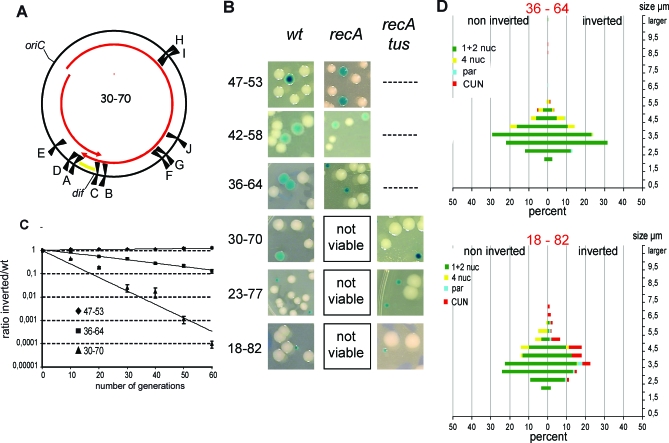
Imbalance of Replication Arms(A) Schematic representation of the E. coli chromosome after interreplichore inversion leading to a 20% imbalance (replication arms are 30% and 70% of the total length of the chromosome). The two replication arms are indicated by red arrows, and the replication fork trap is indicated in yellow. The ten Ter sites (from A to J), replication origin oriC, and dif site are indicated.(B) Colonies of strains carrying chromosomes with various levels of imbalance as indicated (47–53: strain Inter R-L3; 42–58: strain Inter R-L5; 36–64: strain Inter R-NSleft1; 30–70: strain Inter R-NSleft2; 23–77: strain Inter R-NSleft4; and 18–82: strain Inter R-O1). Colonies were obtained in a wt, recA, or recA tus genetic background.(C) Quantification of the growth defects caused by replication arms imbalance. Strains carrying a chromosome with 3% (47–53), 14% (36–64), or 20% (30–70) of replication arms imbalance described in (B) were grown in serial cocultures with the strain carrying the wt configuration. The ratio of inverted to wt configurations is plotted as a function of the number of generations.(D) Comparison of microscopic analyses of strains carrying a chromosome with 14% (36–64) or 32% (18–82) of replication arms imbalance described in (B). Colored horizontal bars indicate the percentage of the different types of cells and nucleoids in the wt (noninverted; left) and inverted (right) configurations. Green indicates cells containing one and two nucleoids (1+2 nuc); yellow: cells containing four nucleoids (4 nuc); cyan: cells containing par-like nucleoids (par); red: cells with unsegregated nucleoid (CUN); and pink: anucleate (anuc).